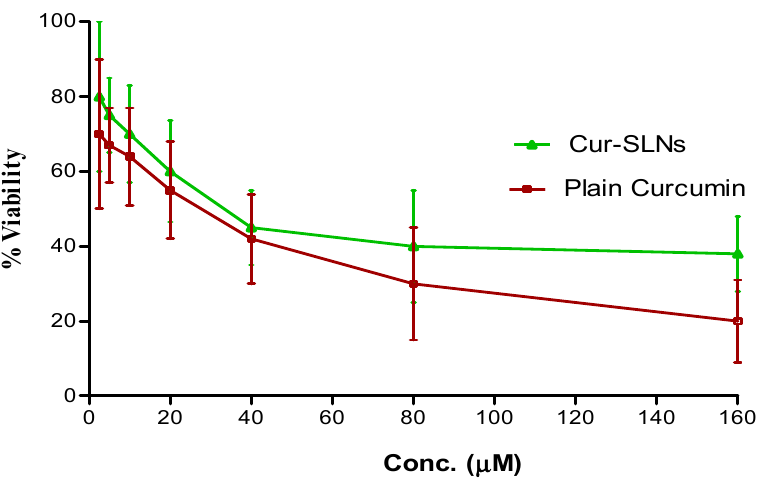
Figure 5. % Viability of curcumin and Cur-SLNs treated A549 cells for 24 h. IC 50 value of Cur-SLNs and plain curcumin are 26.12 ± 1.24 µM and 26.12 ± 1.24 µM, respectively.